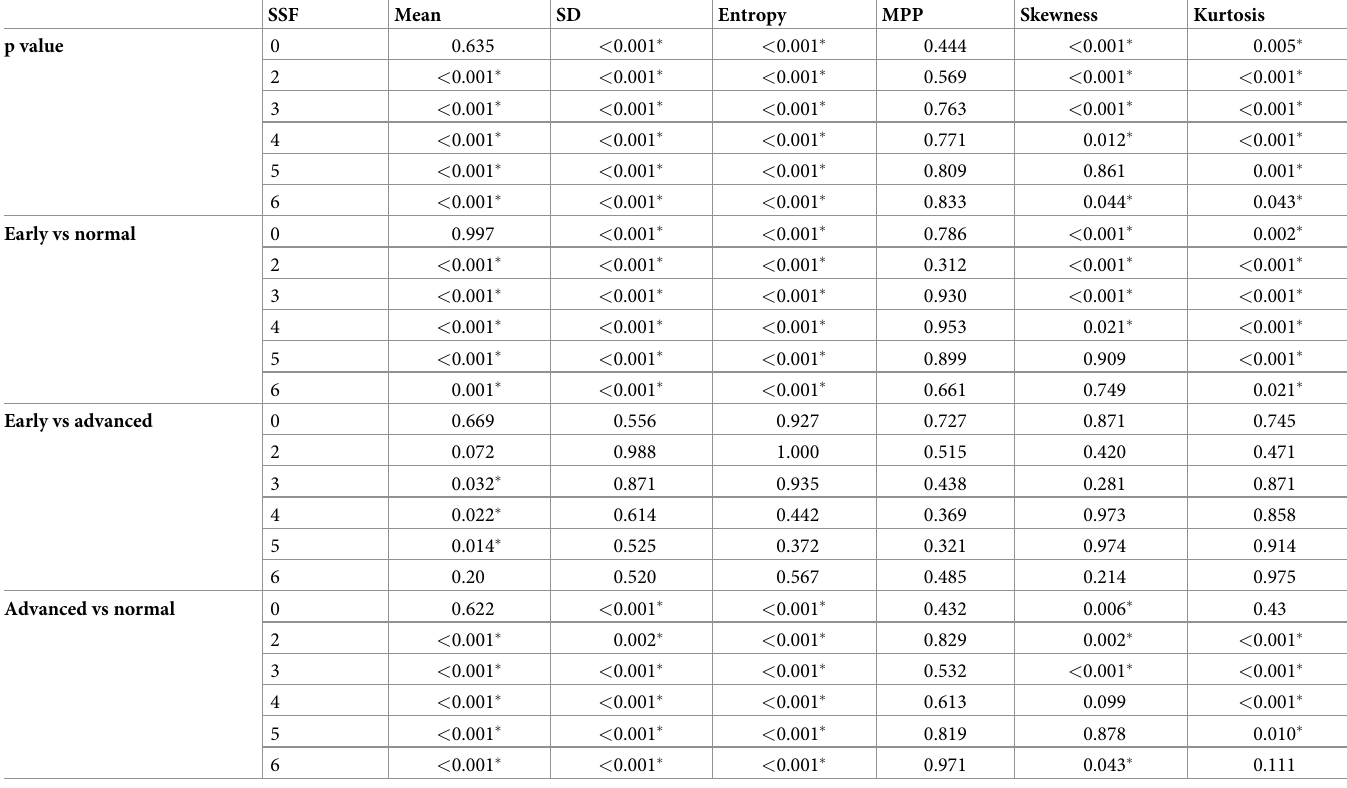
Table 3. Comparisons of texture analysis-derived parameters among normal tonsil, early tonsil cancer, and advanced tonsil cancer.